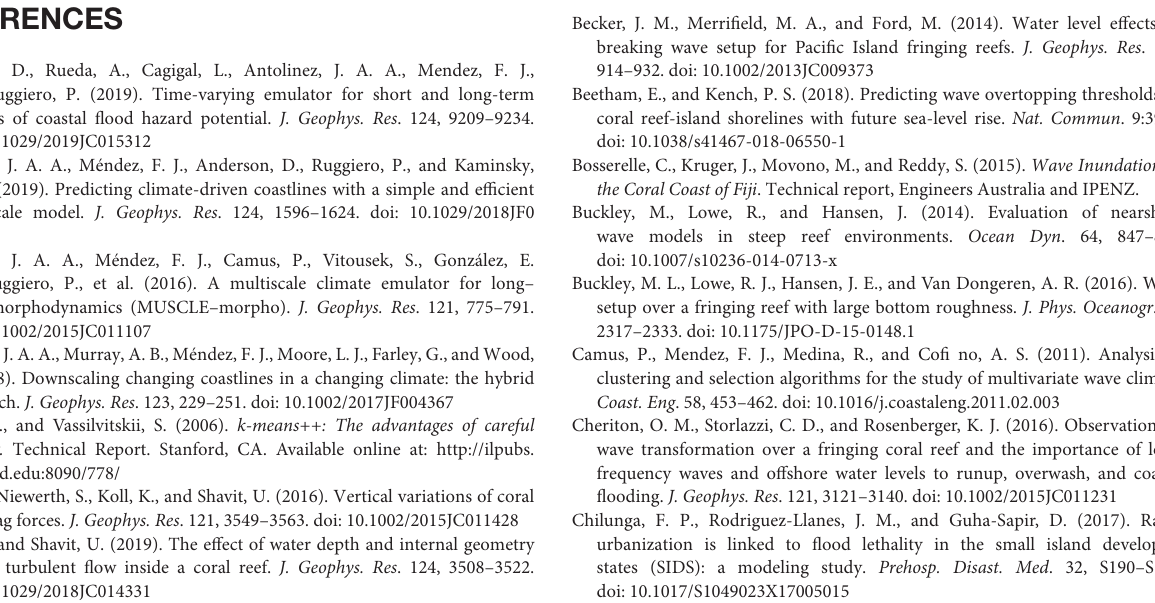
Figure S1 | The 500 initial representative cluster profiles (iRCPs) organized by width. The x-axis corresponds to width and is set from 0 to 7 km and the y-axis corresponds to depth and is set from − 30 to